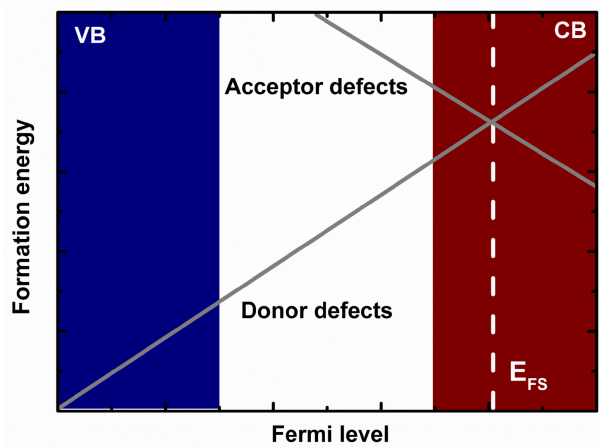
Figure 4. Schematic representation of the formation energy as a function of Fermi level in CdO. The CB and VB are represented by red and blue shading,